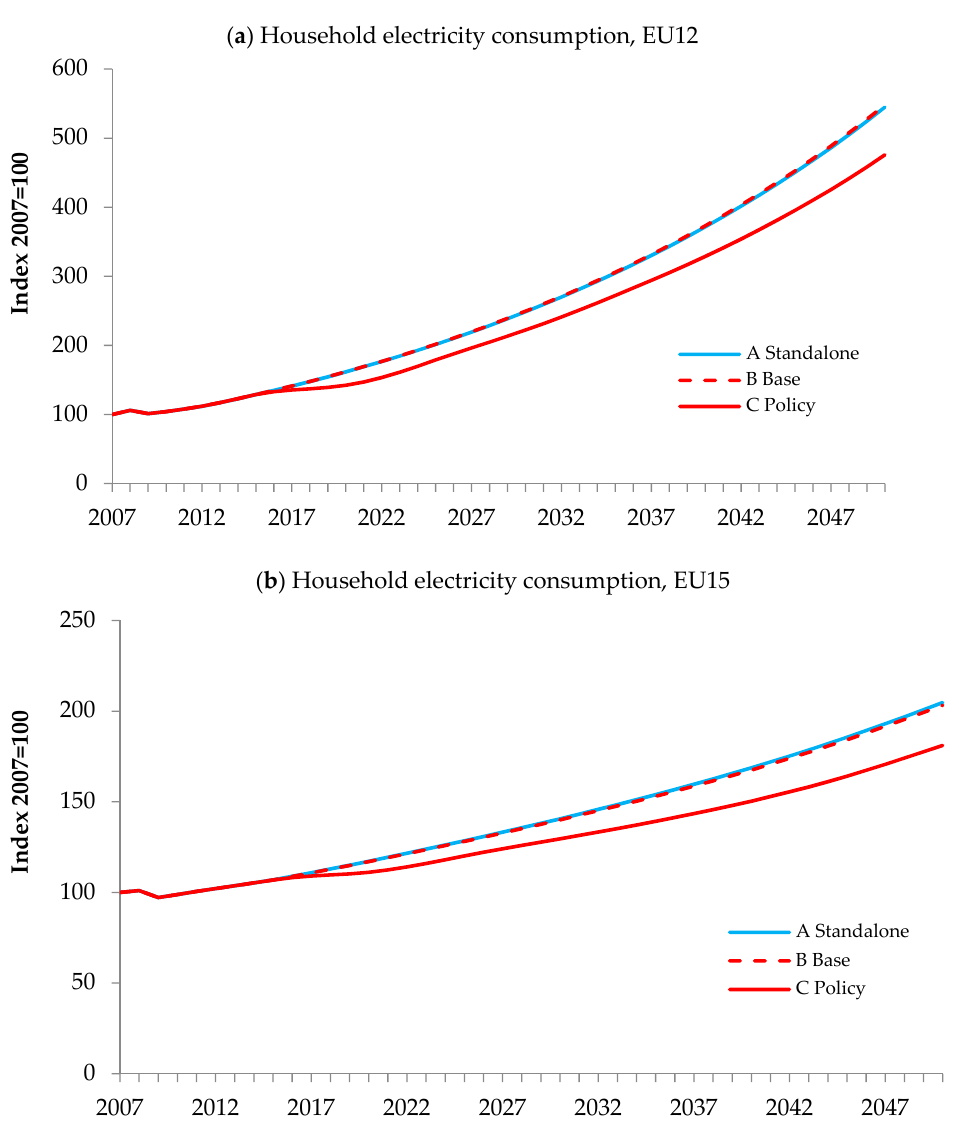
Figure 8. Household electricity consumption, using A, B, and C settings, in ( a ) EU12 countries, and ( b ) EU15 countries.